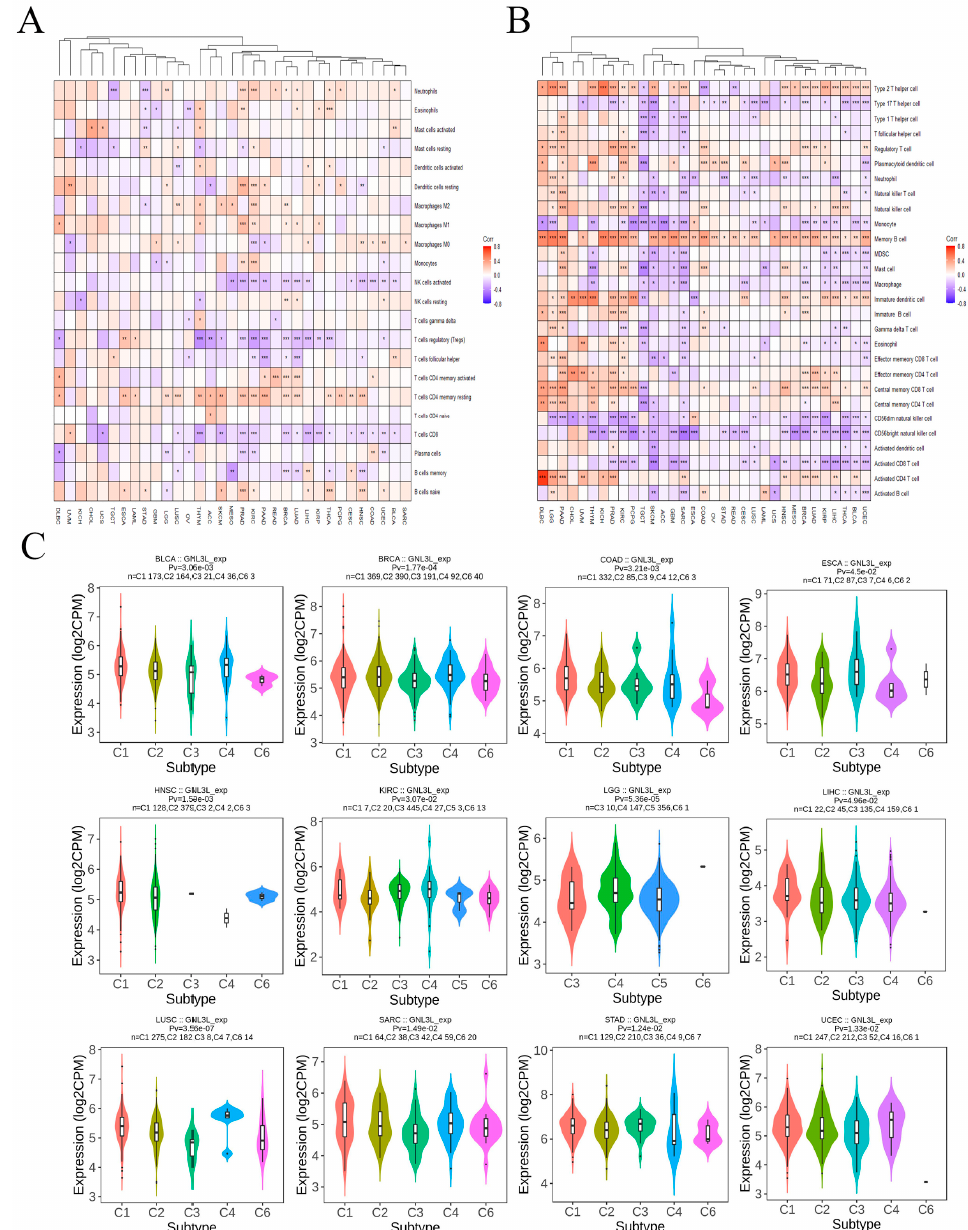
Figure 9. Correlation of GNL3L expression with tumor-infiltrating immune cells. ( A ) Heatmap of GNL3L expression correlation with 22 immune cells based on CIBERSORT algorithm. ( B ) Heatmap of correlation between GNL3L expression and 27 immune cells based on ssGSEA algorithm. ( C ) GNL3L was differentially expressed in different immune subtypes. * p < 0.05; ** p < 0.01 and *** p <